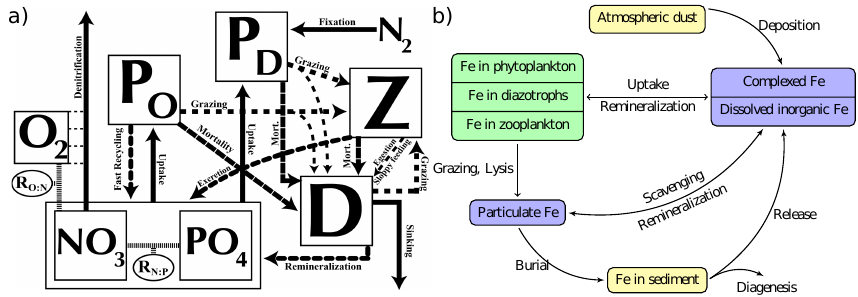
Figure2 Fig.1. Ecosystemmodel schematic whichillustratestheflux (ar- Figure 1. (a) Schematic of the previous ecosystem model, which did not include a dynamic iron cycle, illustrating the flux of material rows)of material betweenmodel variables(squares).Seetextfora between model variables (reprinted from Fig. 1 in Keller et al., 2012). (b) Schematic of the new iron cycle that is implemented into the detaileddescriptionofthesefluxes. previous model. Assuming that complexation and dissociation are very fast processes, the two new iron tracer are dissolved iron which is assumed to be bioavailable and particulate iron which is assumed to not be bioavailable. Yellow boxes indicate external reservoirs of iron, blue boxes not living iron species in the ocean and green boxes the living iron species in the